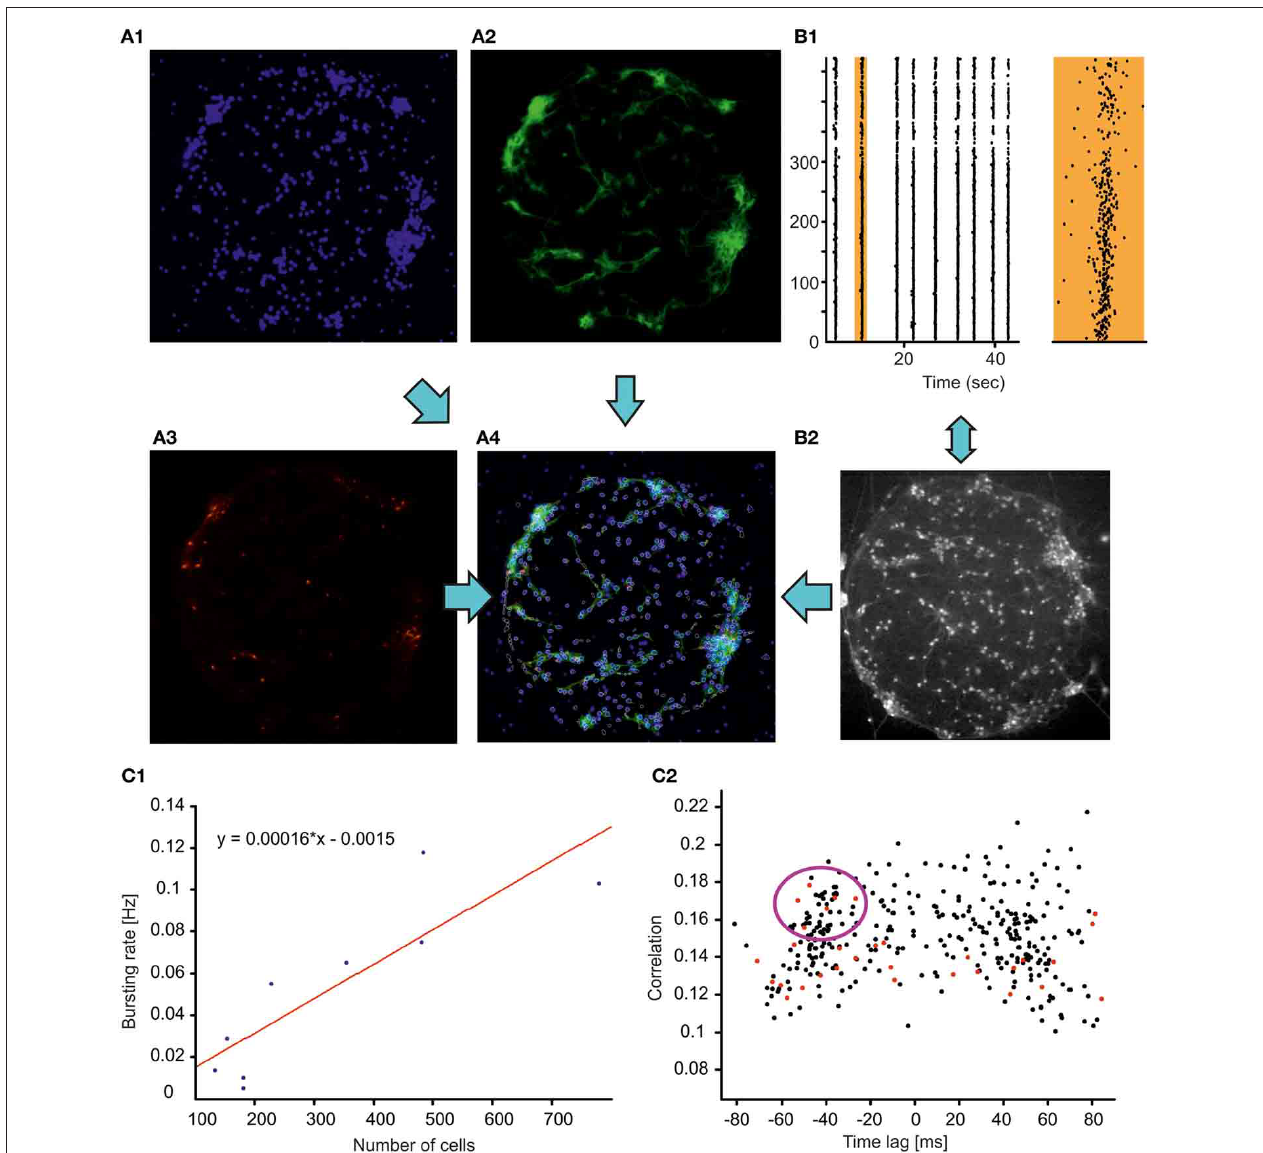
FIGURE 2 | Structure vs . function relations in neocortical finite circuits. (A) Immunocytochemical staining revealing cellular nuclei (blue, DAPI, A1 ), neuronal cells (green, MAPs, A2 ), GABAergic neurons (red, GAD67, A3 ). In panel (A4) , the contours of the cells monitored through calcium imaging (white) are superimposed to the merged immunocytochemical pictures. (B) Monitoring the dynamics of the neuronal circuit through calcium imaging. Raster plot ( B1 left plot) of the activity of the circuit (shown in panel A ) displaying stereotyped spontaneous network synchronizations (broken vertical lines). The activity of a representative network synchronization (marked in orange) is shown with higher temporal resolution on the right orange plot (bottom scale bar 0.5s). The cells loaded with the calcium indicator OGB are shown in the panel (B2) (objective magnification 10 × , field